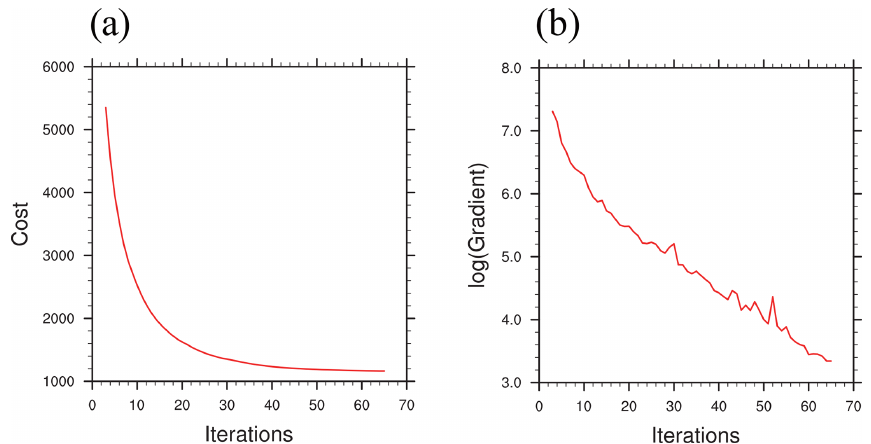
Figure 6. (a) Cost function and (b) gradient as functions of